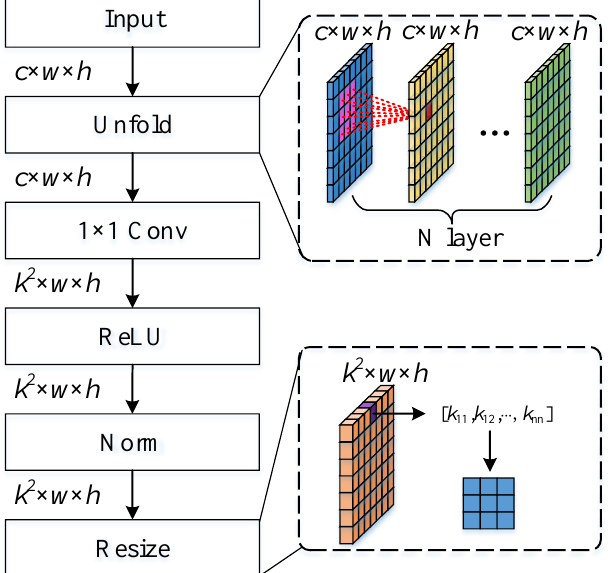
Figure 3. Local weight generation module network structure, where Unfold represents the sliding window implementation, and Resize represents the resize element of each